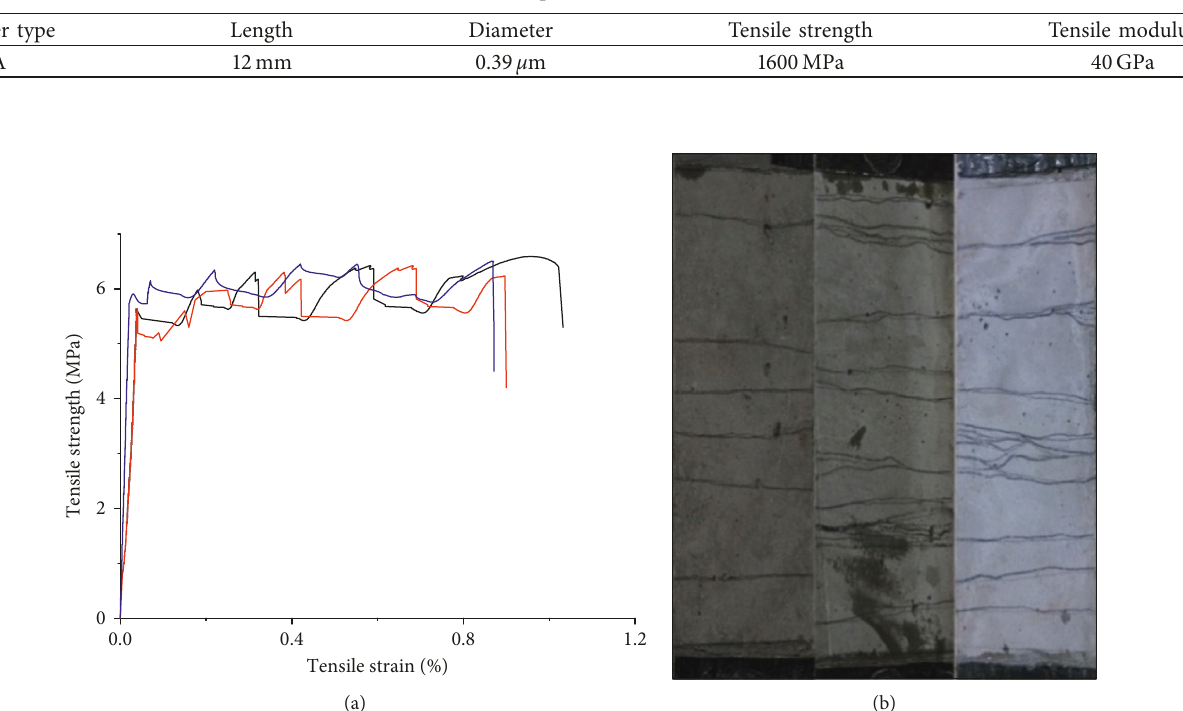
Figure 1: Stress-strain curves and the crack pattern of HDC. (a) Stress-strain curves and (b) crack